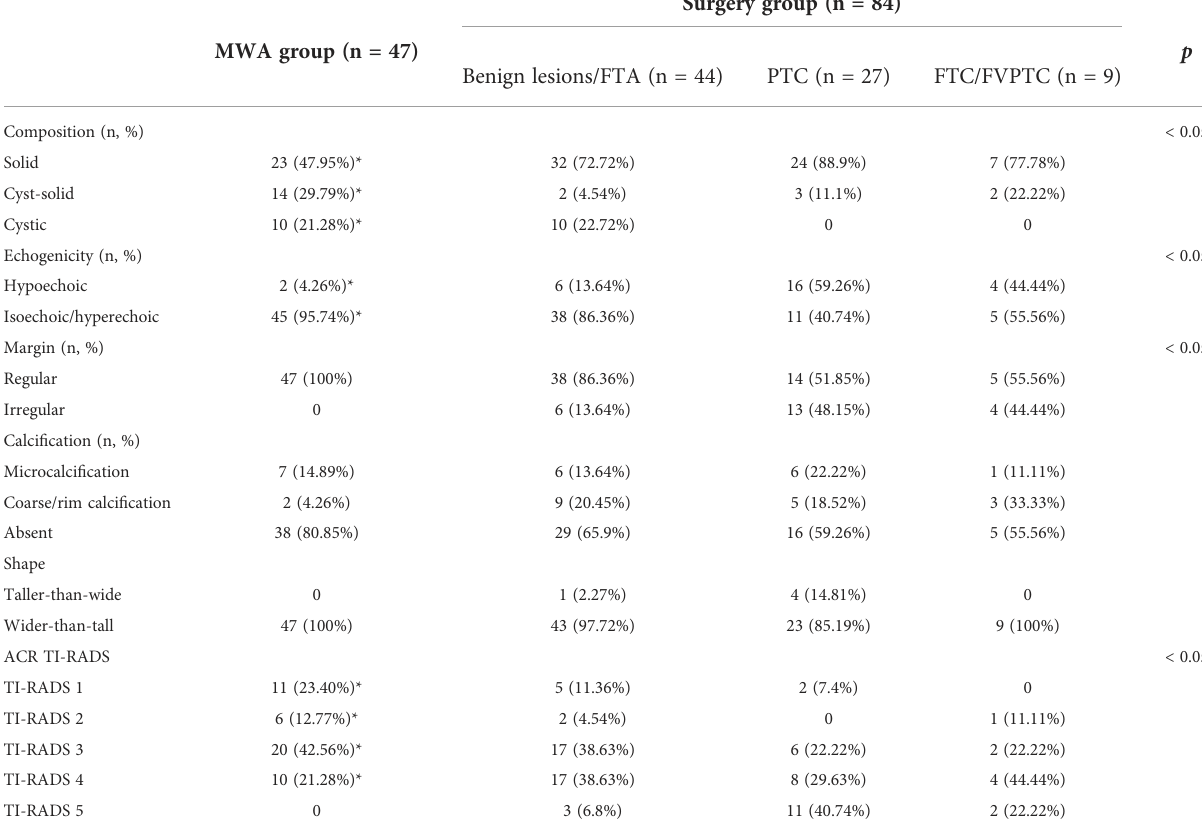
TABLE 2 Preoperative ultrasound characteristics of patients with Bethesda category IV thyroid nodules (n =